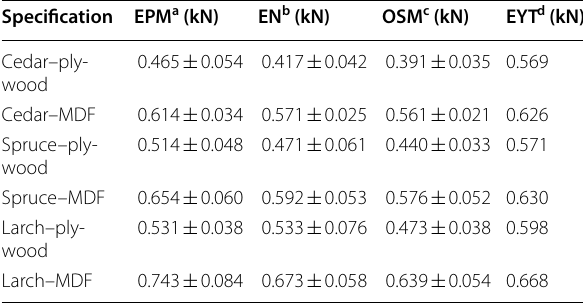
a Yield load obtained using the perfect elasto-plastic model b Yield load obtained using the method described in EN 12512 [26] c Yield load obtained using the offset method d Yield load obtained using European yield theory